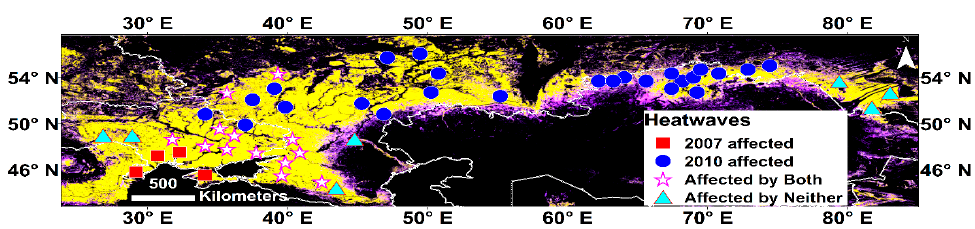
Figure 15. Sites affected by: the 2010 heat wave (blue circles), the 2007 heat wave (red squares), both the 2010 and 2007 heat waves (white stars with pink borders), and sites affected by neither the 2010 nor the 2007 heat wave (cyan triangles).